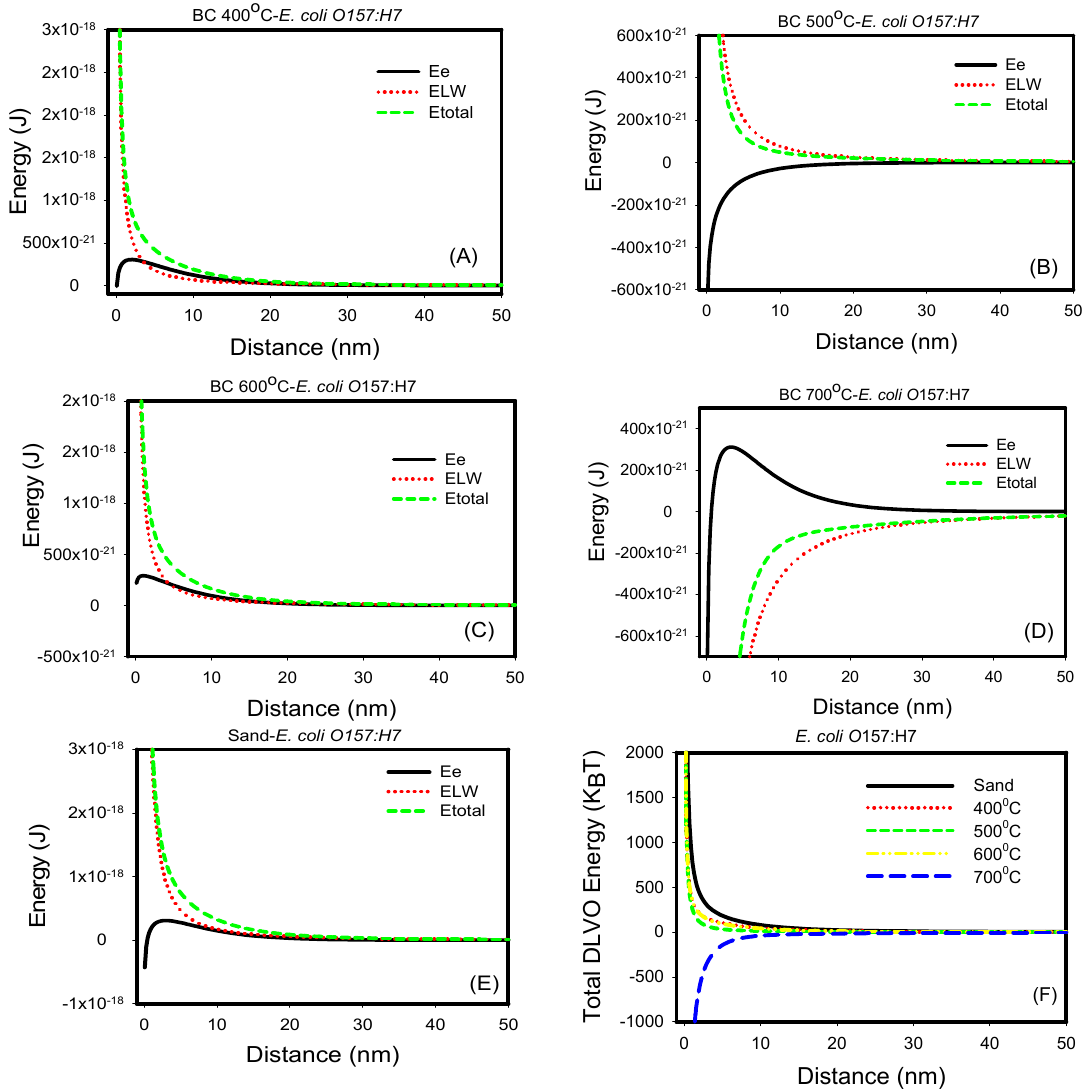
Figure 4. ( A – E ) Electrostatic, van der Waal and total energy profiles as a function of distance for interactions between E. coli O157:H7 and biochars 400, 500, 600, and 700 °C and sand in DIW. ( F ) Comparison of all total energy profiles between E. coli O157:H7 and all biochars and sand in water. The total energy profiles quantified between biochars and E. coli O157:H7 were statistically different ( p < 0.001).